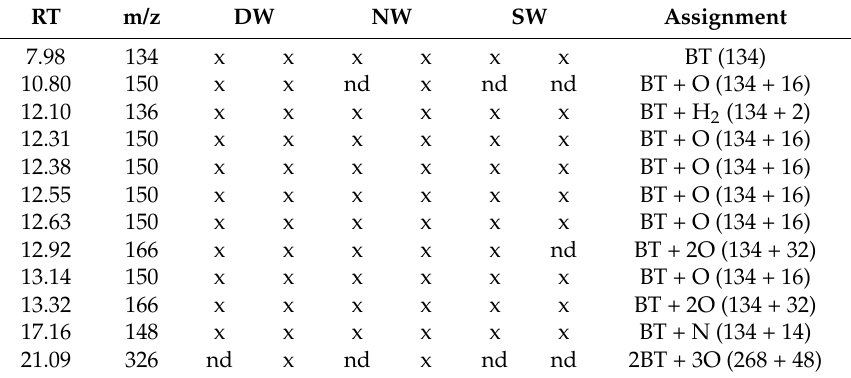
Table 1. The retention time and molecular ion peaks of BT degradation products observed after 5 min of ultrasonic treatment at 352 kHz for deionized (DW), natural (NW) and synthetic sea waters (SW). RT m/z DW NW SW Assignment